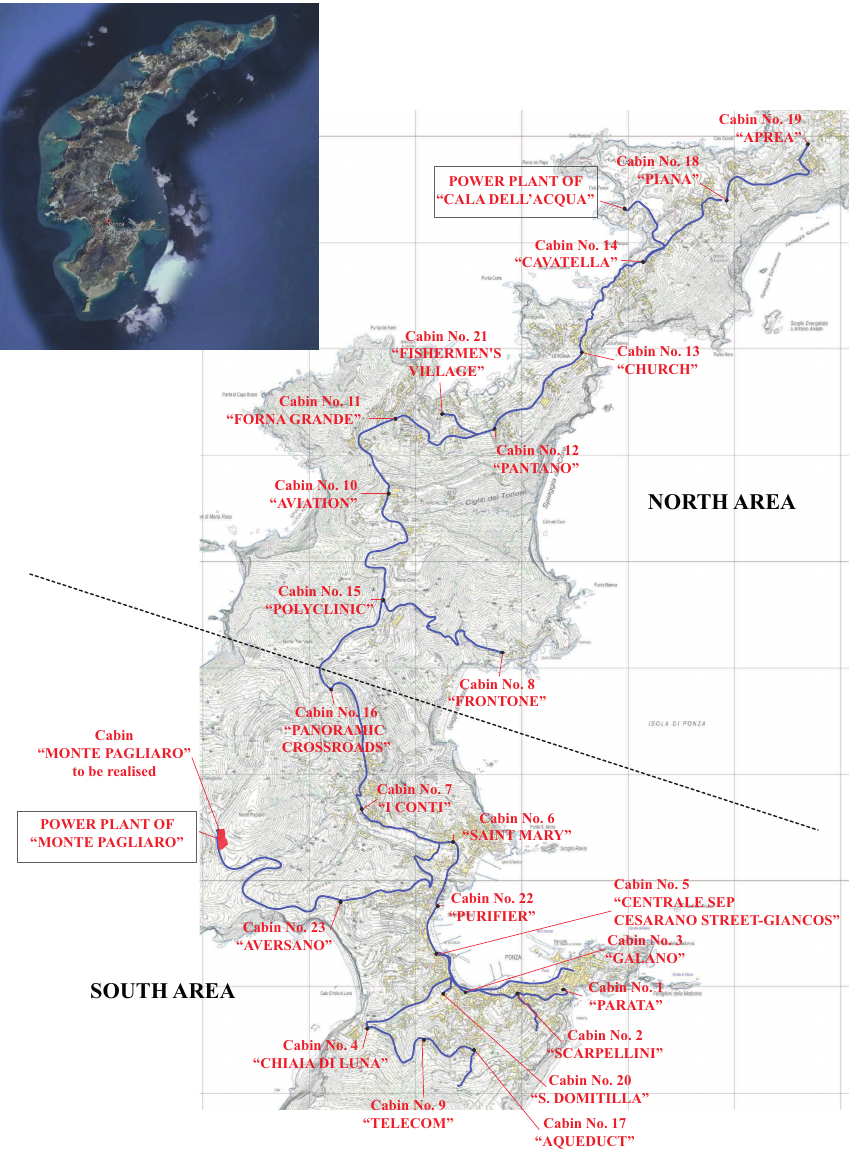
Figure 1. Development of the electricity grid on the island of Ponza with the two power